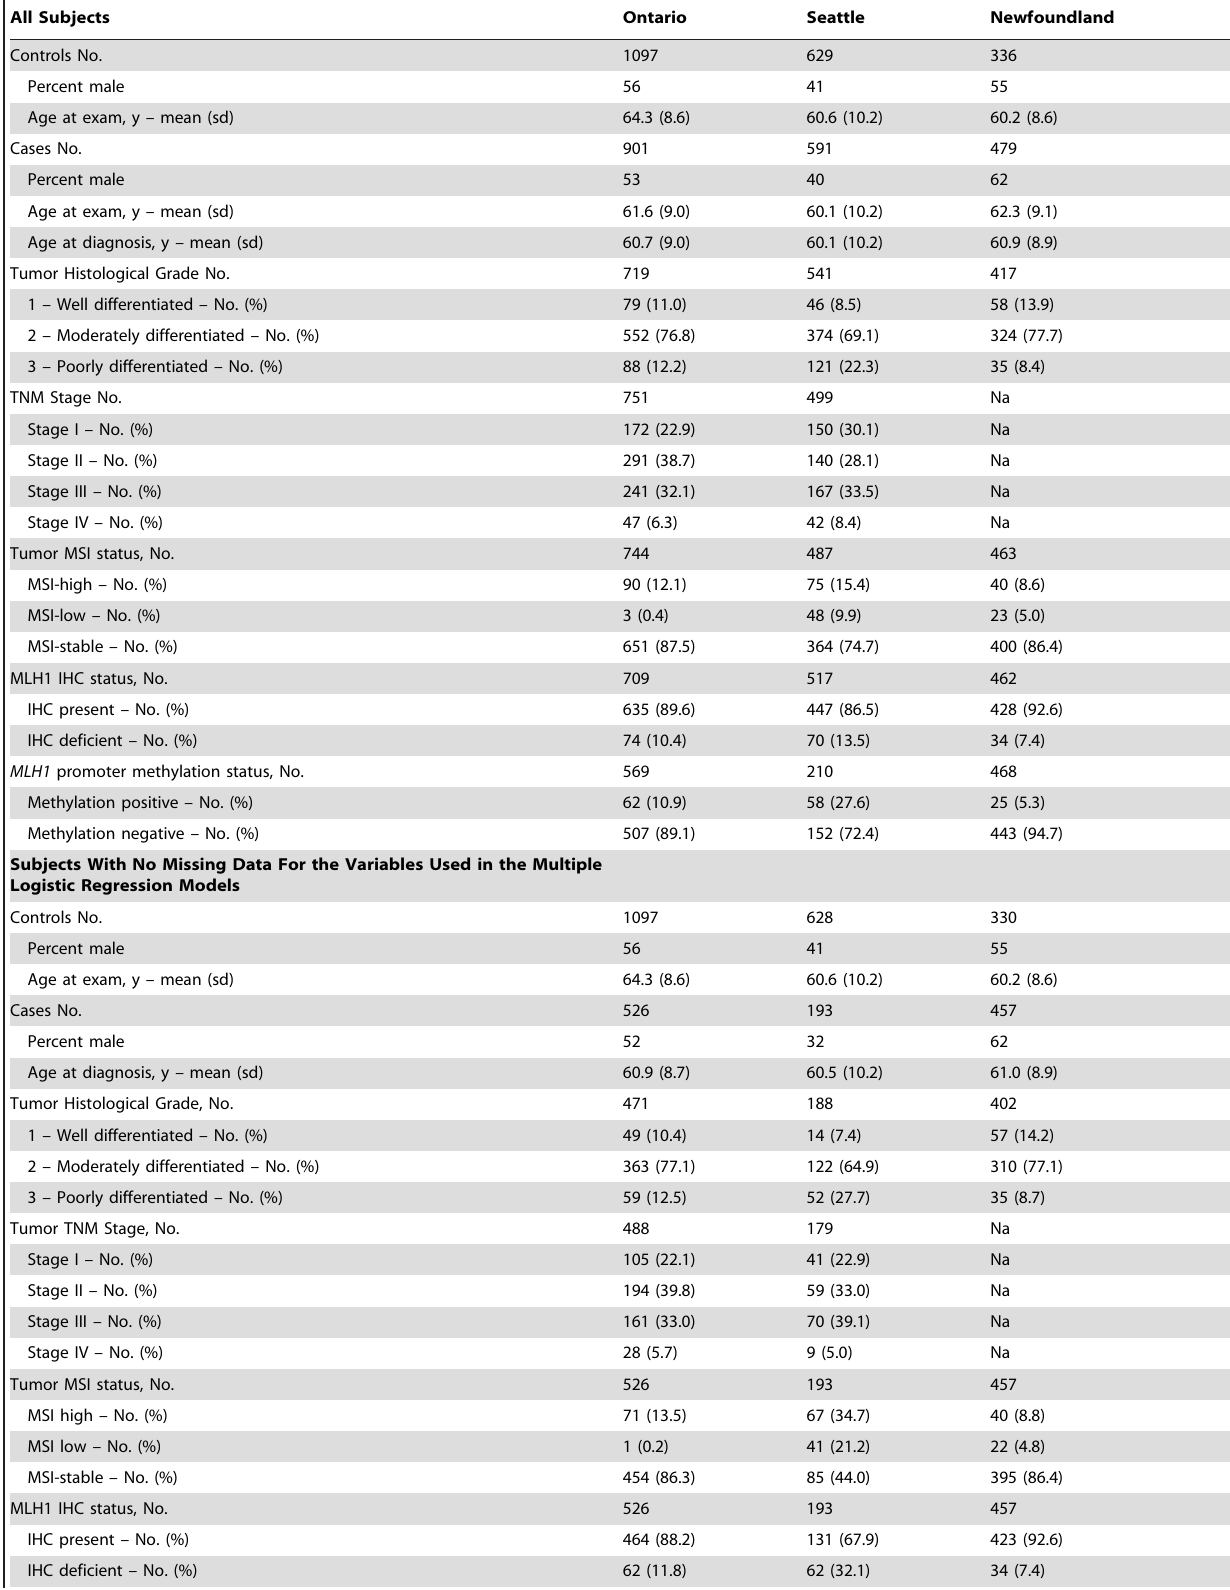
Table 1. Characteristics of Study